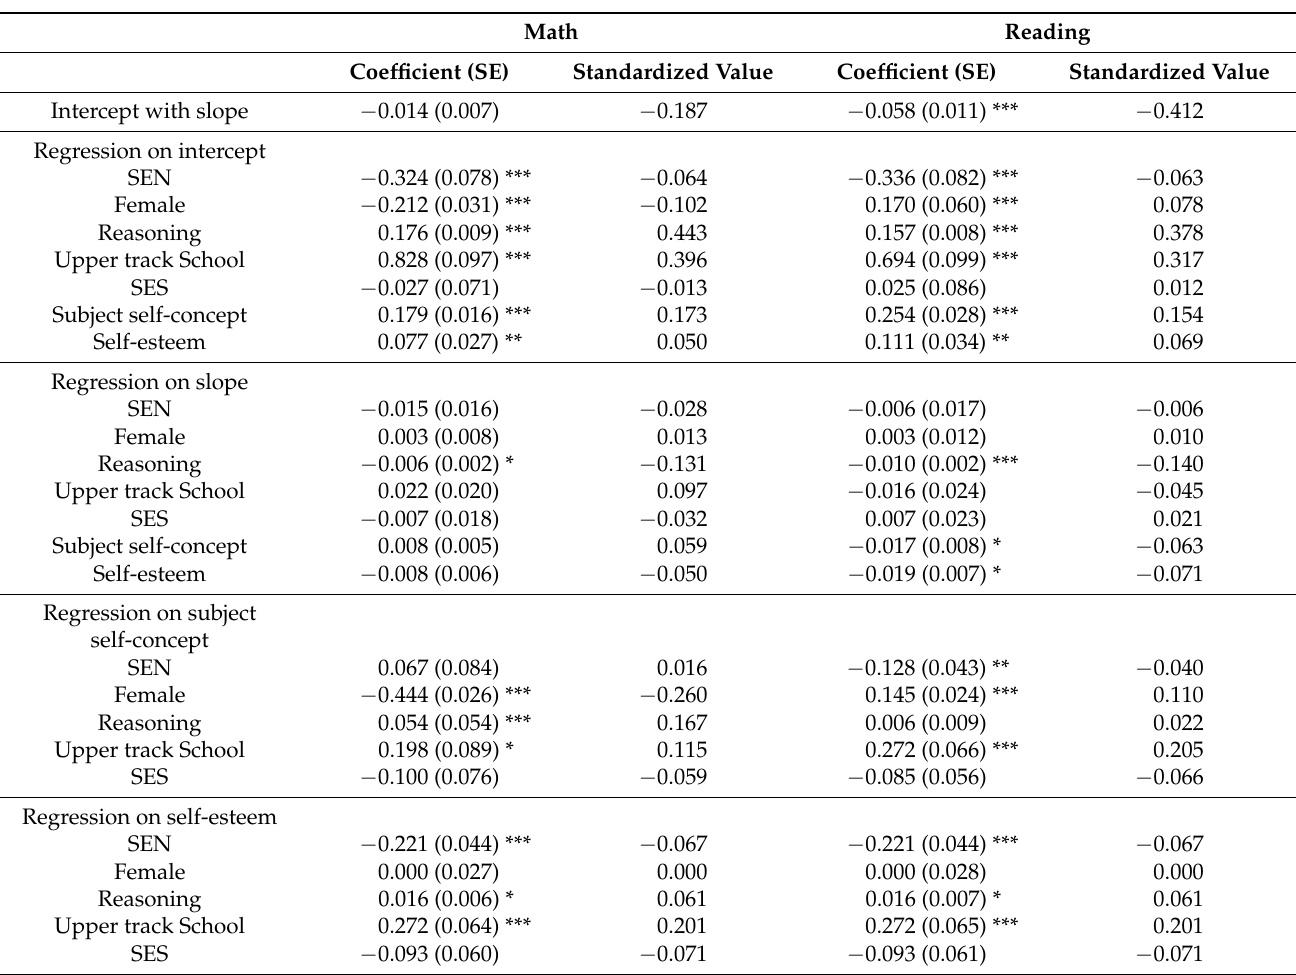
Table 5. Path coefficients—mediation